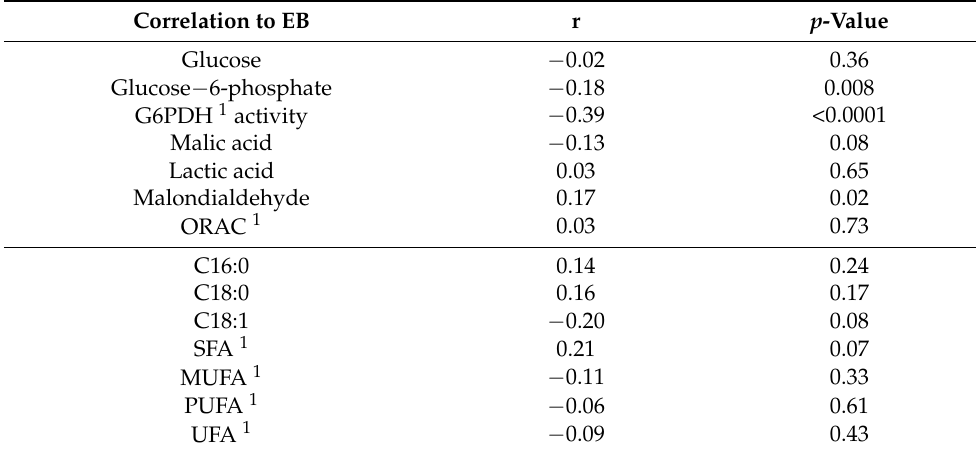
Table 4. Correlations between energy balance (EB) and milk metabolites, oxidative stress markers, and FA composition during the first 45 d in lactation.